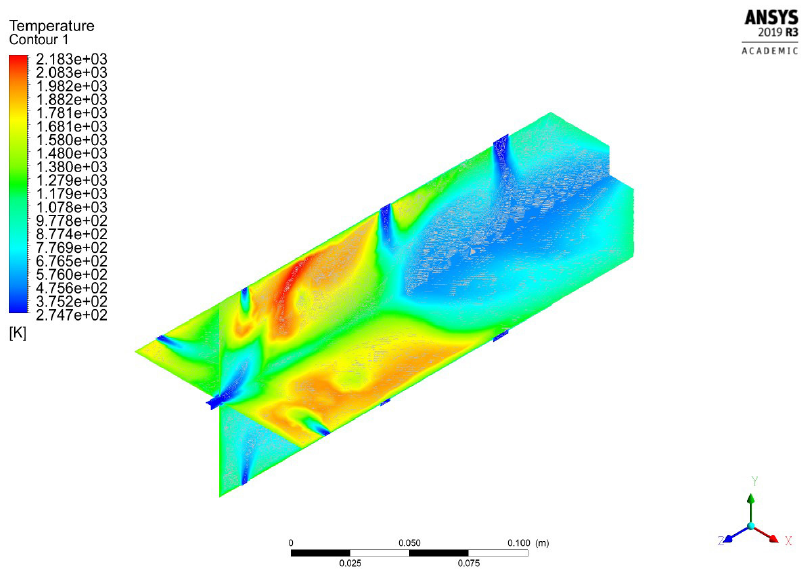
Figure 6. Temperature